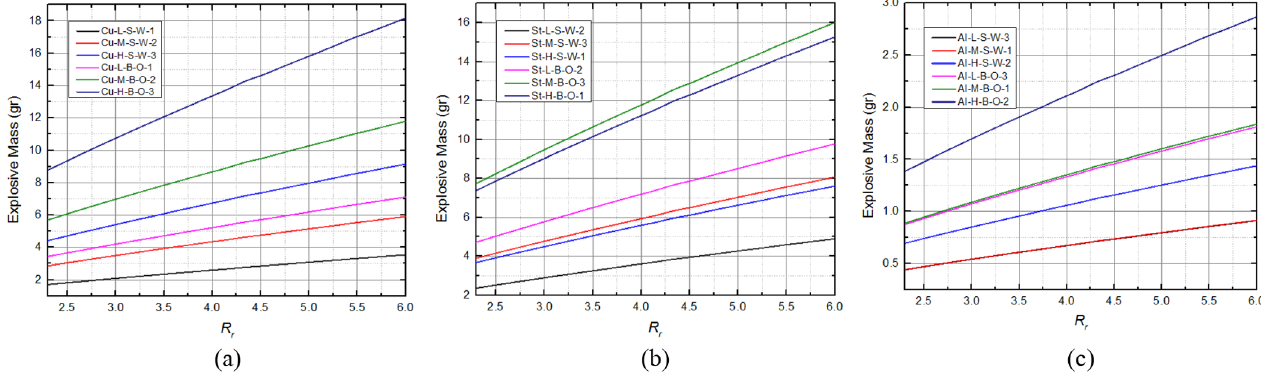
Fig. 9. Variations of estimated explosive mass vs. Rr for (a) copper, (b) steel and (c)